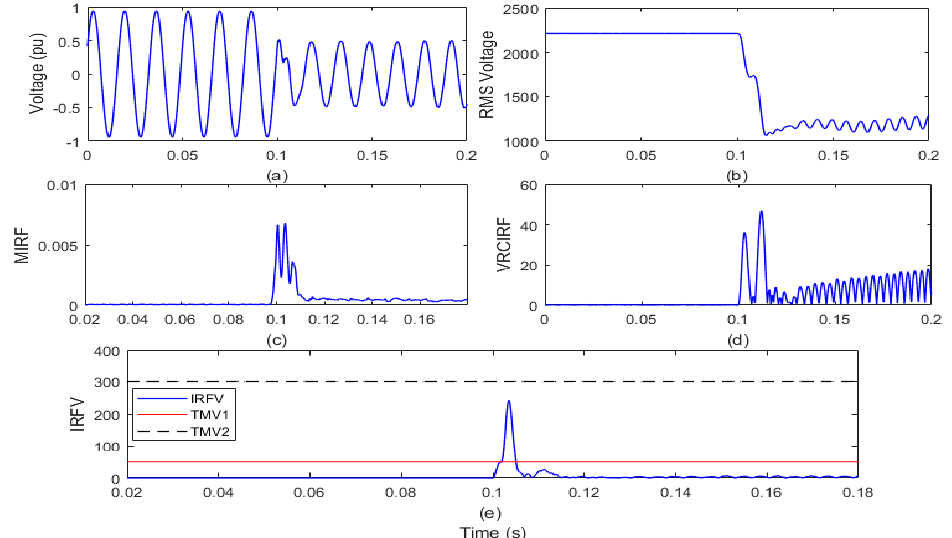
Figure 6. Islanding event in the presence of solar power generation ( a ) voltage signal ( b ) root means square value of voltage ( c ) median-based IRF ( d ) rate of change in voltage-based IRF ( e ) islanding recognition factor based on voltage.